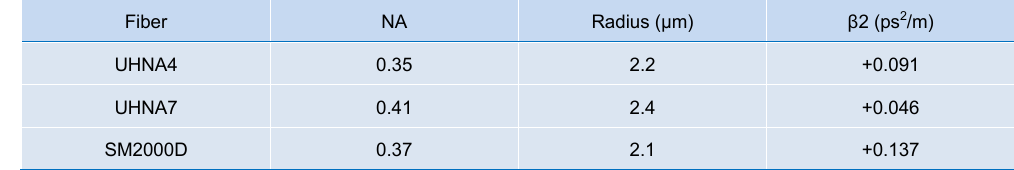
Table 1 | Parameters of commercial UHNA